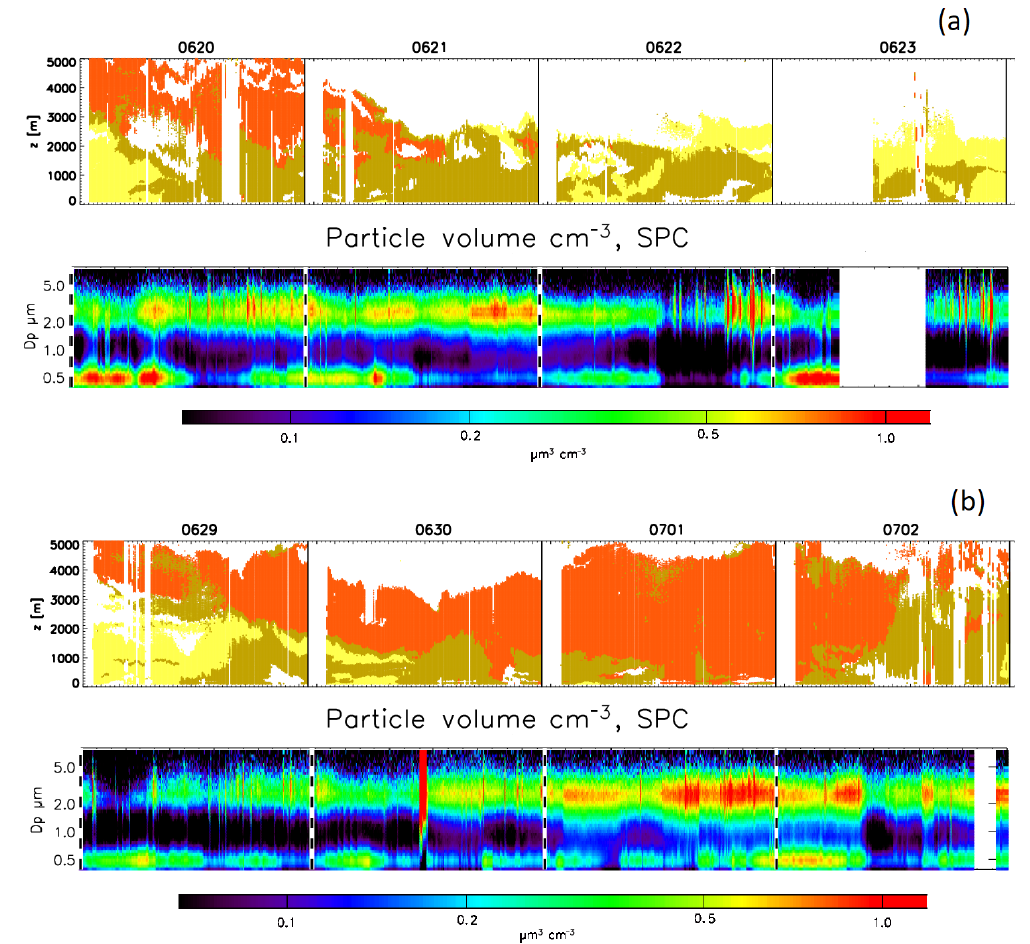
Figure 5. Vertical profiles of aerosol particle types (upper panels), as in Fig. 2, and APSS aerosol time series of the volume size distribution of aerosol particles (lower panels), as in Fig. 4, for the first (a) and the second (b) dust event.